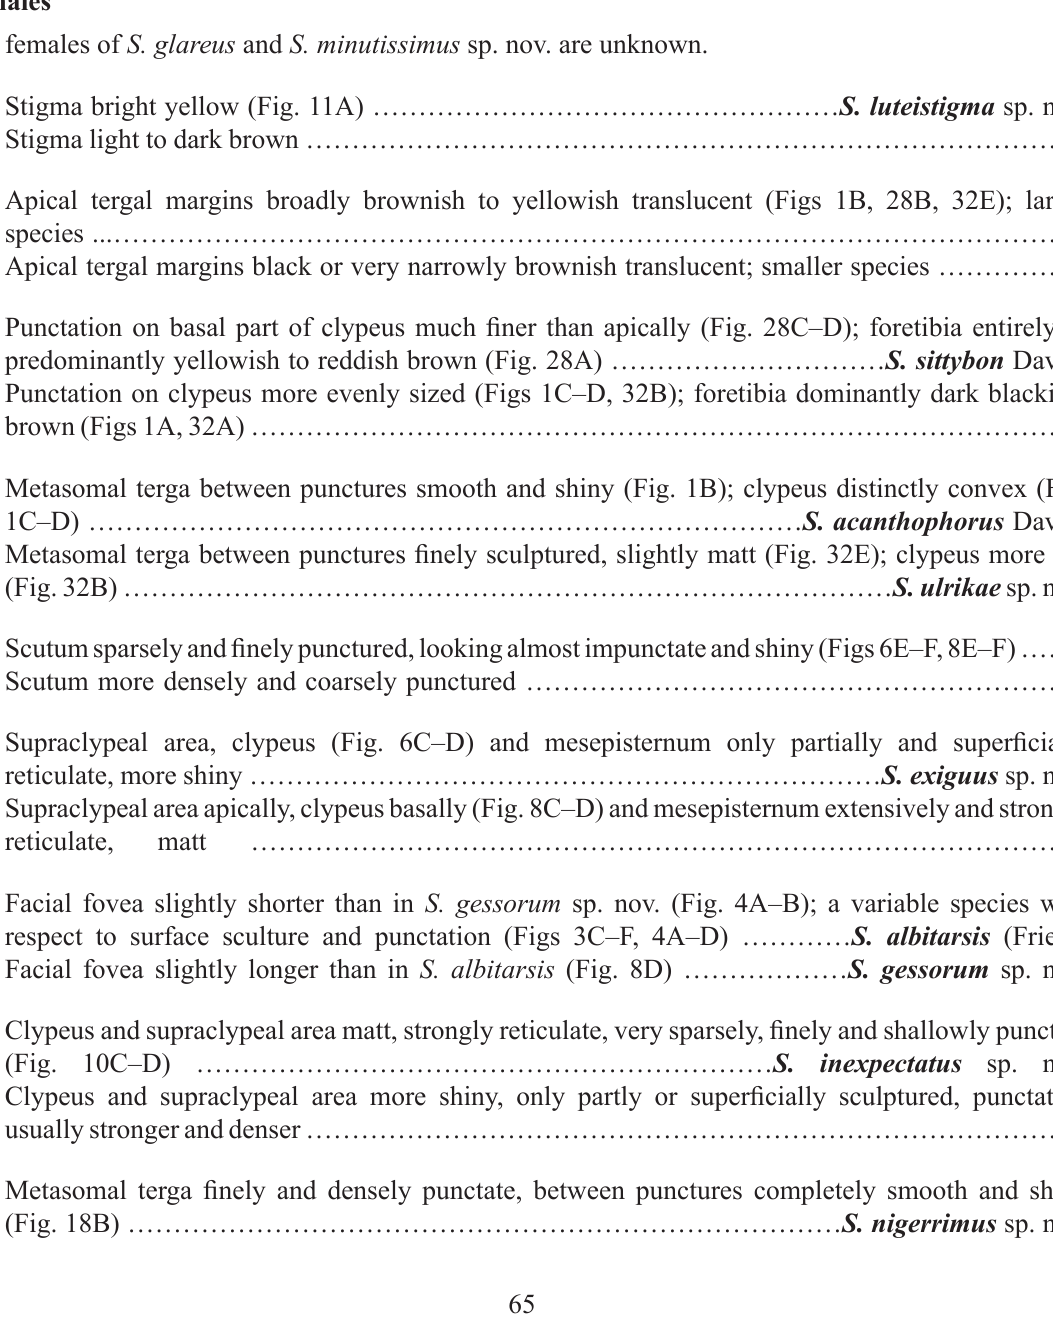
Brassicaceae: white and blue Heliophila sp. Seasonal activity August–September. Key to species of "euryglossiform" Scrapter Due to their small size, the similarity of many species and the subtle, often gradual differences between some of them, identification can be very difficult, particularly in females. For males it is generally recommended to dissect genitalia and hidden sterna S7 and S8. Females The females of S. glareus and S. minutissimus sp. nov. are unknown. 1 – 2 Apical tergal margins broadly brownish to yellowish translucent (Figs 1B, 28B, 32E); larger – Apical tergal margins black or very narrowly brownish translucent; smaller species ……………5 3 Punctation on basal part of clypeus much finer than apically (Fig. 28C–D); foretibia entirely or predominantly yellowish to reddish brown (Fig. 28A) ………………………… S. sittybon Davies – Punctation on clypeus more evenly sized (Figs 1C–D, 32B); foretibia dominantly dark blackish- 4 Metasomal terga between punctures smooth and shiny (Fig. 1B); clypeus distinctly convex (Fig. – Metasomal terga between punctures finely sculptured, slightly matt (Fig. 32E); clypeus more flat 5 Scutum sparsely and finely punctured, looking almost impunctate and shiny (Figs 6E–F, 8E–F) ……6 – 6 Supraclypeal area, clypeus (Fig. 6C–D) and mesepisternum only partially and superficially – Supraclypeal area apically, clypeus basally (Fig. 8C–D) and mesepisternum extensively and strongly reticulate, matt Facial fovea slightly shorter than in S. gessorum sp. nov. (Fig. 4A–B); a variable species with respect to surface sculture and punctation (Figs 3C–F, 4A–D) ………… S. albitarsis (Friese) – Facial fovea slightly longer than in S. albitarsis (Fig. 8D) ……………… S. gessorum sp. nov. 8 Clypeus and supraclypeal area matt, strongly reticulate, very sparsely, finely and shallowly punctate – Clypeus and supraclypeal area more shiny, only partly or superficially sculptured, punctation 9 Metasomal terga finely and densely punctate, between punctures completely smooth and